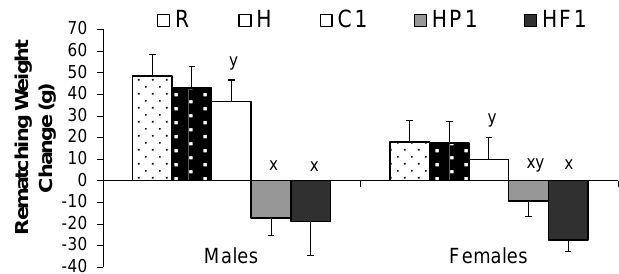
Figure 2. Body weight and weight gain of rats over the six week re-matching period following an eight week period of high fat, high sucrose diet consumption. Values are means ± SEM, n = 10 per group except n = 4 for group H. * represents a significant ( p < 0.05) difference between HF1 and C1. ** represents a significant ( p < 0.05) difference within HF1 between 23 and 28 weeks. For weight change, treatments with different letters are significantly different between diets ( p < 0.05): superscripts x,y indicate significant difference between C1, HP1, HF1. There were no differences between R, H and C1.